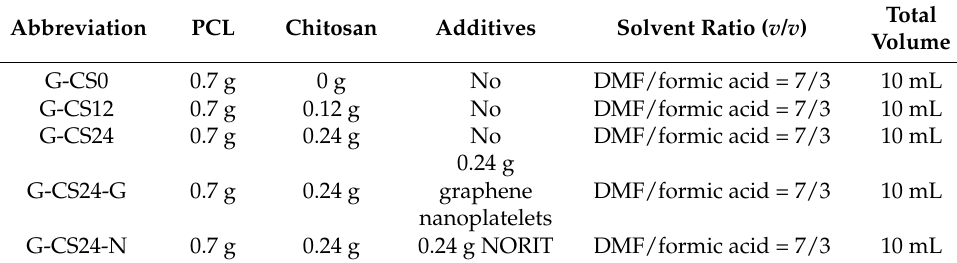
Table 1. The precursor solution list for the fabrication of PCL/CS porous